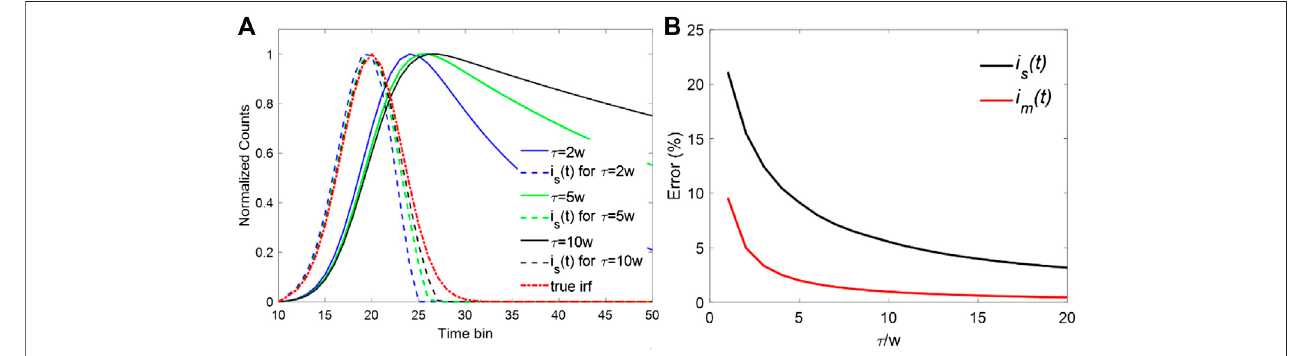
FIGURE 1 | (A) Decay curves with different lifetimes and their synthetic IRFs. (B) Errors for i s (t) and i m (t) when τ /w is changing from 1 to 10.